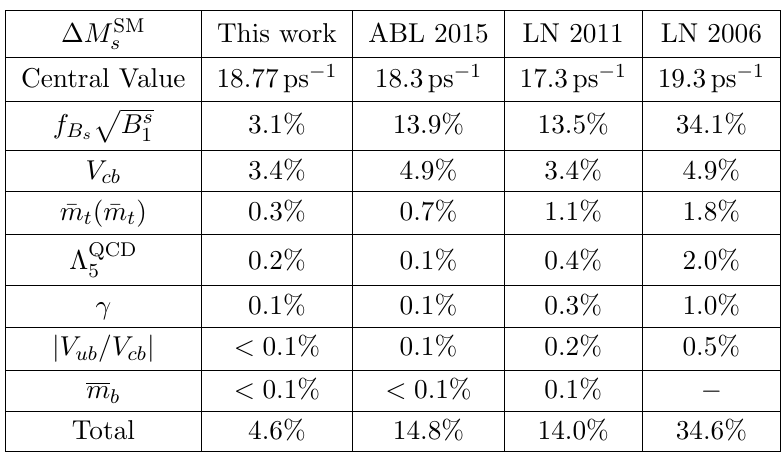
Table 12 . List of the individual contributions to the theoretical error of the mass di(cid:11)erence (cid:1) M s within the Standard Model and comparison with the values obtained in 2015 [31], in 2011 [128] and in 2006